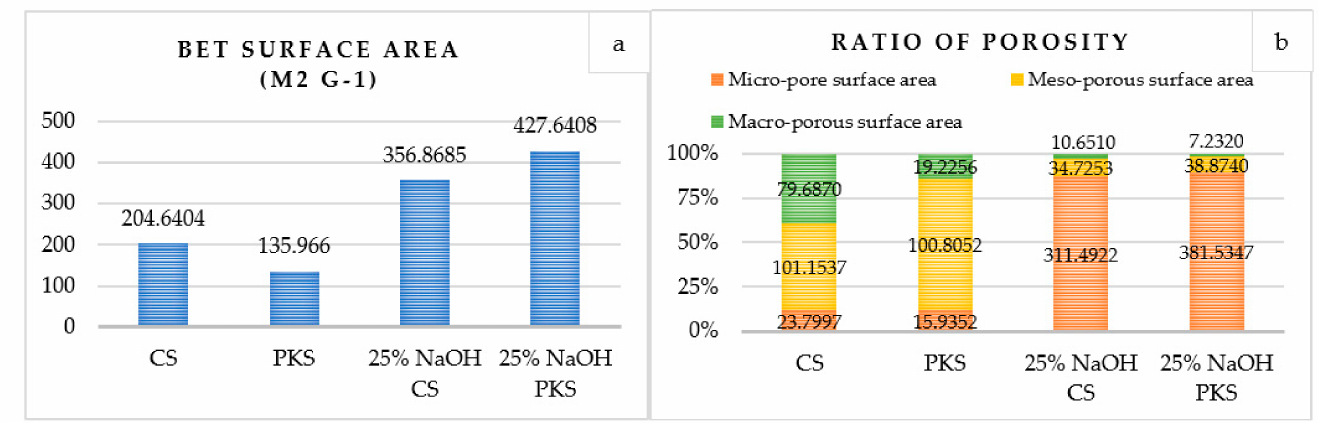
Figure 1. Surface characteristics of activated carbon: ( a ) BET surface area and ( b ) porosity ratio for activated carbon prepared at 700 ◦ C for 75 min (reference sample) and activated carbon (700 ◦ C, 75 min) post-treated with 25% NaOH.